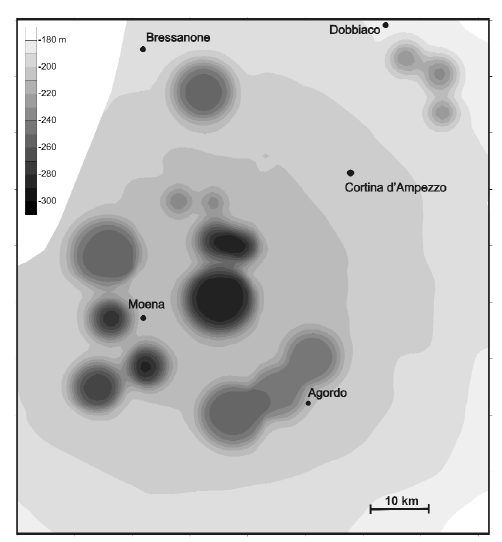
Fig. 7. Map of the calculated subsidence induced by the growth of all Late Anisian-Early Ladinian carbon- ate platforms. Both elastic (regional) and plastic (lo- cal) contributions are evident and can be easily quan- tified. The round geometry of the local contributions is due to the simplified shape of the carbonate bodies assumed in the model. The contour lines of induced subsidence are in meters (see grey scale). The maxi- mum regionally induced subsidence is concentrated in the Central Dolomites and amounts to about 220 m, while local contributions range between 40 and 90